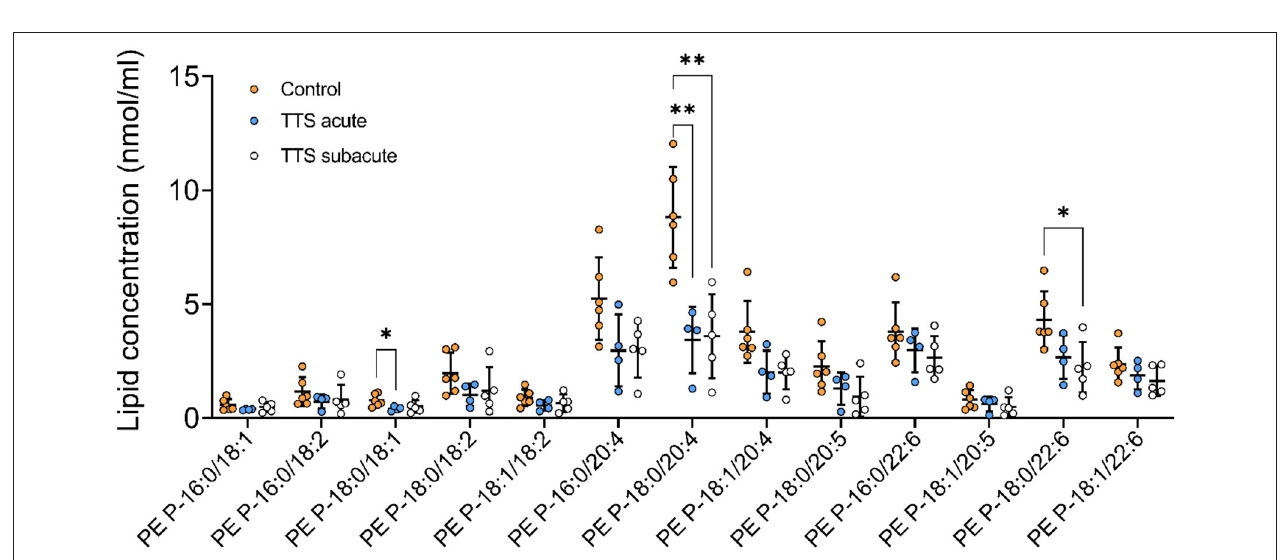
FIGURE 5 | Composition of individual PE lipid species in the acute TTS, subacute TTS, and control groups. Values are represented as nmol/ml. Values are mean ± SD, P -value: * P < 0.05. Where significance is not mentioned, values are considered as being not significant. PE, Phosphatidylethanolamine; TTS, Takotsubo syndrome.